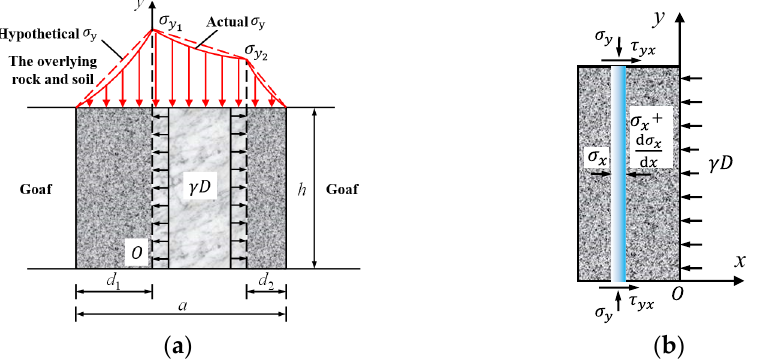
Figure 3. Mechanical model of pillar under valley terrain: ( a ) schematic diagram of mechanical analysis of pillar; and ( b ) schematic diagram of mechanical analysis of yield zone (the left yield zone).